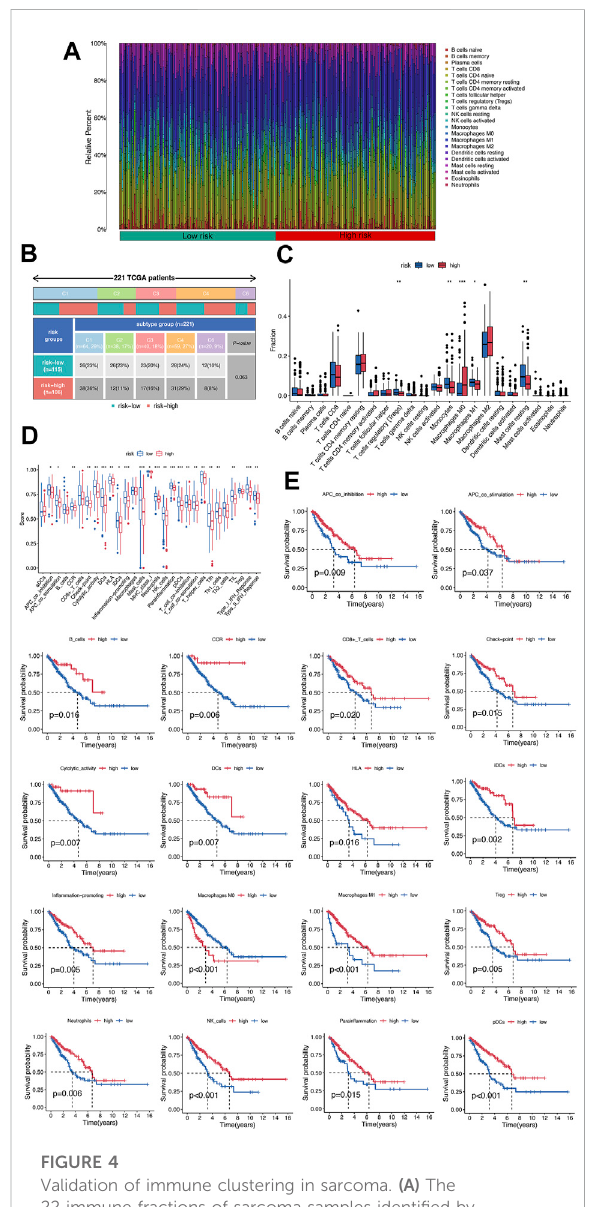
FIGURE 4 Validation of immune clustering in sarcoma. (A) The 22 immune fractions of sarcoma samples identi fi ed by CIBERSORT. (B) The classi fi cation of 221 sarcoma samples based on the risk score and immune subtypes. (C) The 22 immune fractions of sarcoma samples classi fi ed by risk score. (D) The function score of 29 immune gene sets identi fi ed by ssGSEA. (E) The Kaplan – Meier survival curves of immune gene sets,